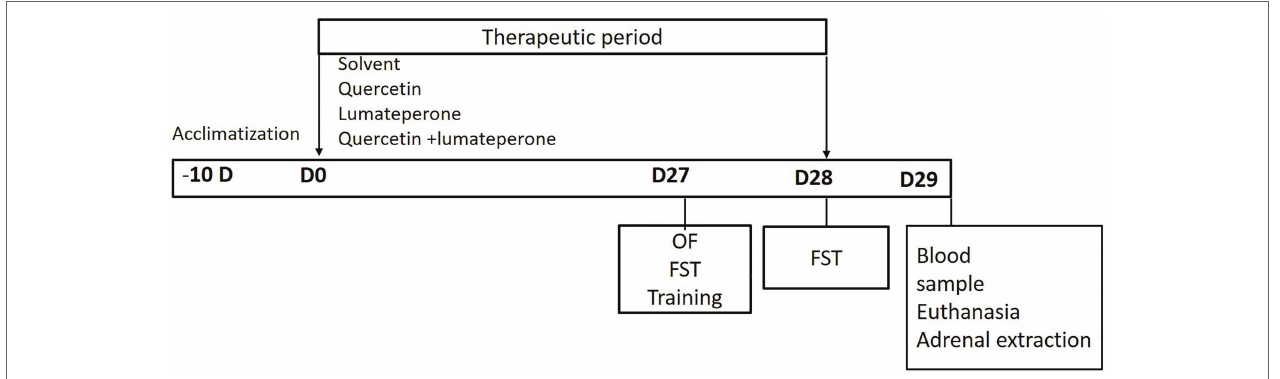
FIGURE 2 | Study timeline diagram illustrating the duration of acclimatization of animals 10 days before the start of therapeutic intervention ( − 10D), the duration of therapeutic intervention from day 0 (D0) to day 28 (D28), and the timing of different study tests; open field test (OF) on day 27 (D27), Forced swim test (FST) training session on D27, FST on day 28 (D28), blood sample and animal euthanasia for adrenal extraction on day 29